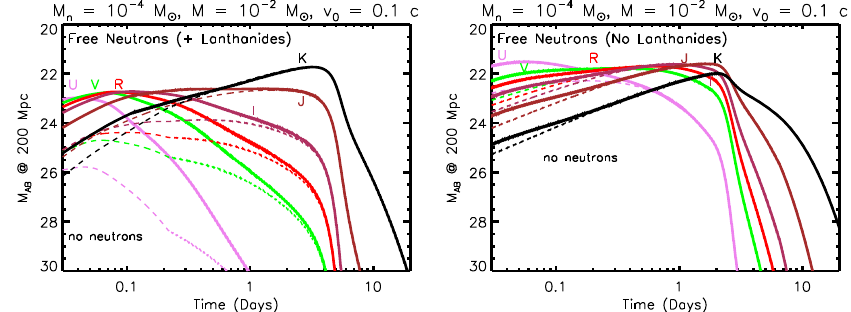
Fig. 6 Kilonova light curves, including the presence of free neutrons in the outer M n = 10 − 4 M (cid:4) mass layersoftheejecta(“neutronprecusors”),calculatedforthesameparametersoftotalejectamass M = 10 − 2 and velocity v 0 = 0 . 1 c used in Fig. 5. The top panel shows a calculation with an opacity appropriate to lanthanide-bearing nuclei, while the bottom panel shows an opacity appropriate to lanthanide-free ejecta. Models without a free neutron layer ( M n = 0; Fig. 5) are shown for comparison with dashed lines